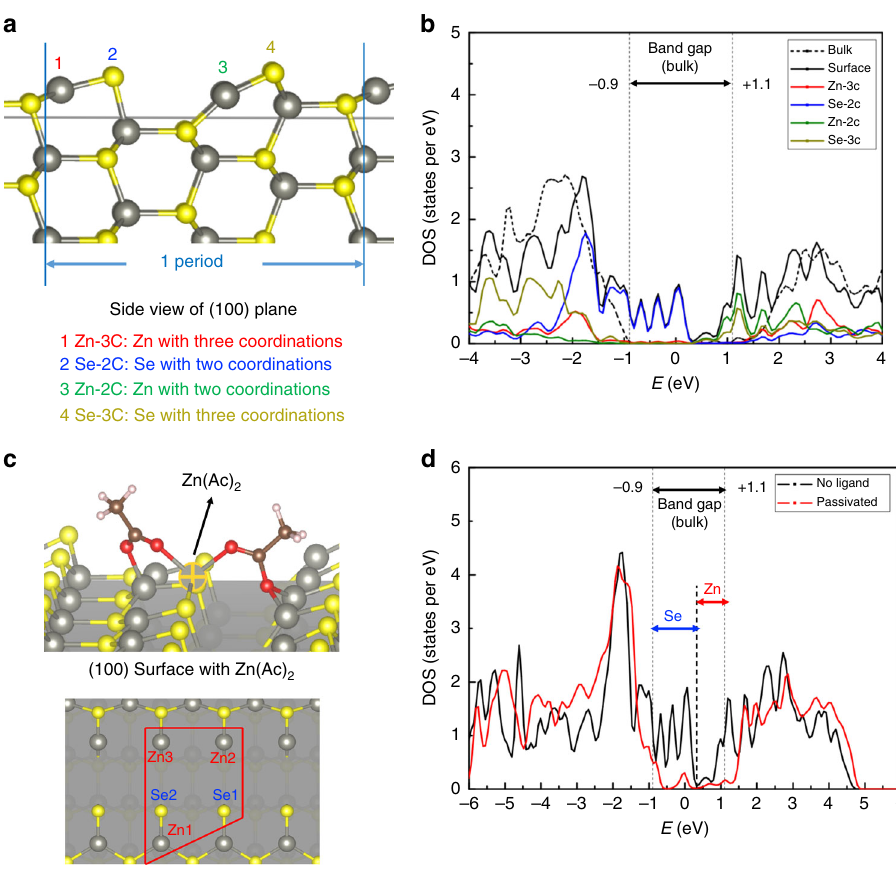
Fig. 1 Simulation of QD surface. a The under-coordinated Zn and Se atoms on Wurtzite (100) ZnSe surface. b Density of states (DOS) of bulk ZnSe, and projected density of states (pDOS) of (100) ZnSe surface and under-coordinated Zn and Se atoms on (100) surface. c The bonding con fi guration of Zn (Ac) 2 to ZnSe (100) surface. Zn1, Zn2, Zn3, Se1, and Se2 are the bonding sites of Zn(Ac) 2 on ZnSe (100) surface. Top fi gure is the 3D illumination of the bonding con fi gurations, and the bottom fi gure is the top view of the bonding sites of atoms on the (100) surface. d The density of states (DOS) before and after Zn(Ac) 2 passivation, the Se and Zn labels indicate which atom are most responsible for the speci fi c reduction of mid-gap states.